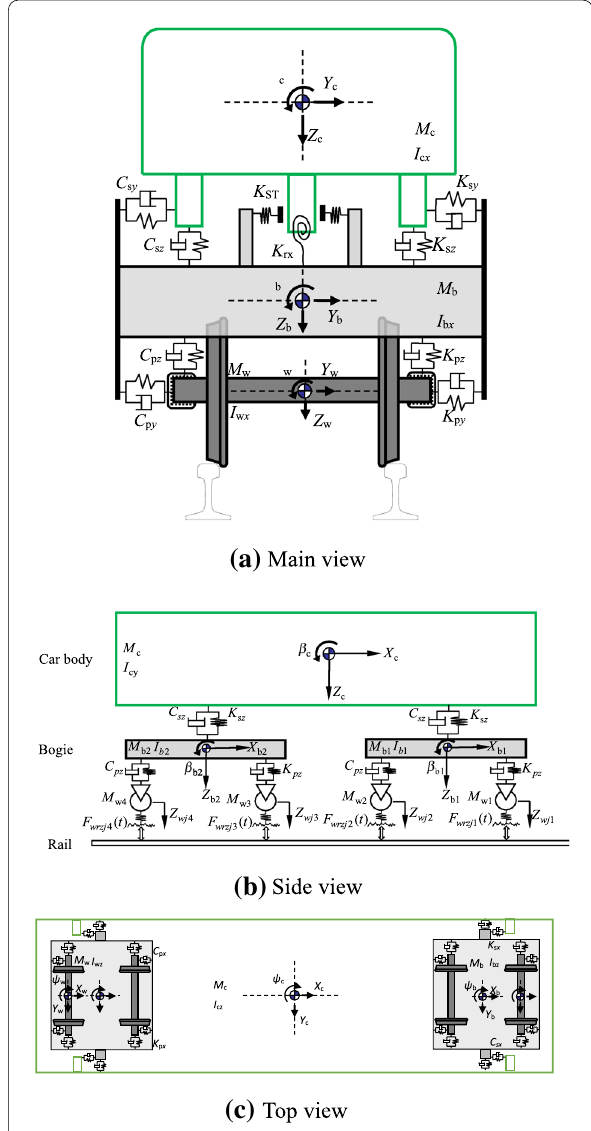
Figure 2 Three views of subway vehicle dynamic model